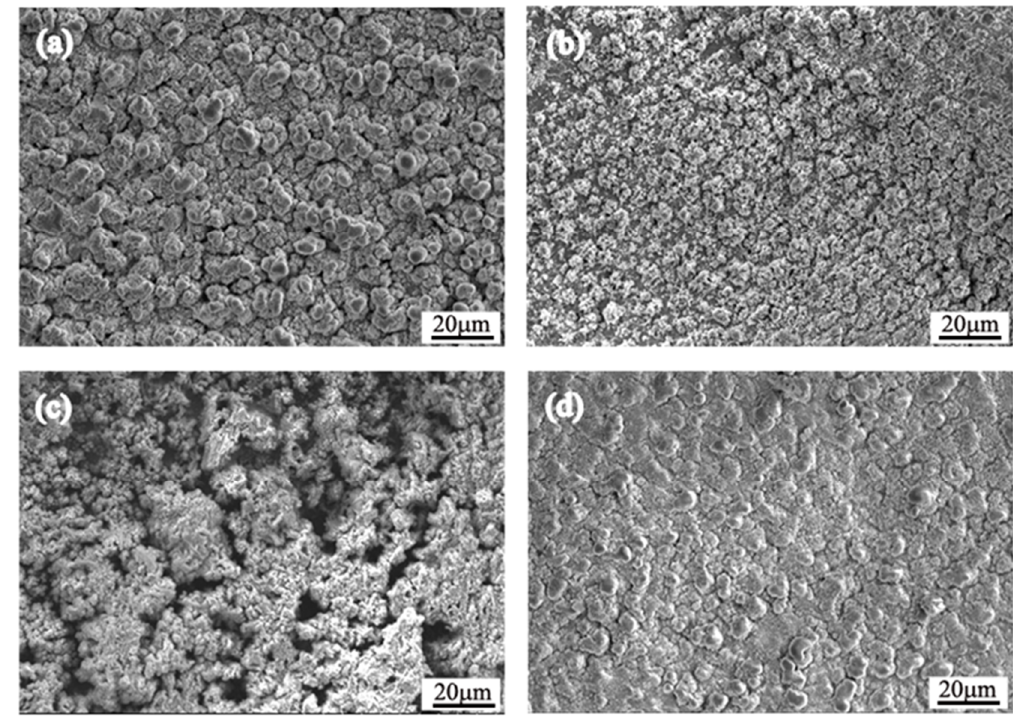
Figure 3. Oxide products on the surface of rusty samples after 144 h immersion tests ( a ) Q235B ( b ) Q235BM ( c ) Q355B ( d ) Q355BM.